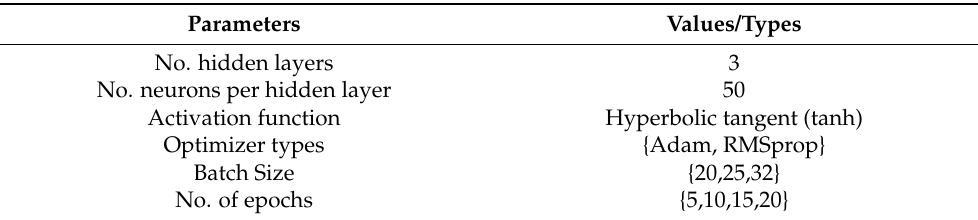
Table 3. Hyperparameters of LSTM model that considered for